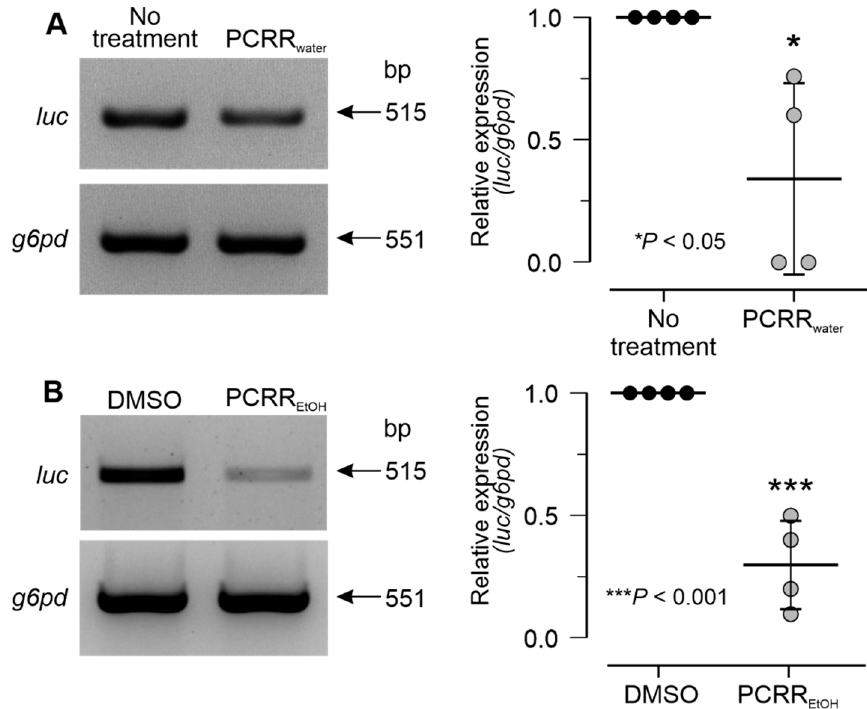
Figure 6. PCRR water and PCRR EtOH inhibit pseudovirus entry in the zebrafish test. Larvae at 3 dpf were pre-treated with ( A ) PCRR water or ( B ) PCRR EtOH before being co-treated with the respective PCRR extracts and the SARS-CoV-2 PEG-pseudovirus for 72 h. PCR amplification of whole larval cDNA indicated the relative level of luc expression in both the treatment and control groups. The relative level of luc expression was determined through normalization to the expression level of g6pd . The data represent the mean ± SD; ( n = 4) and statistical differences were detected utilizing the two-sample t -test.